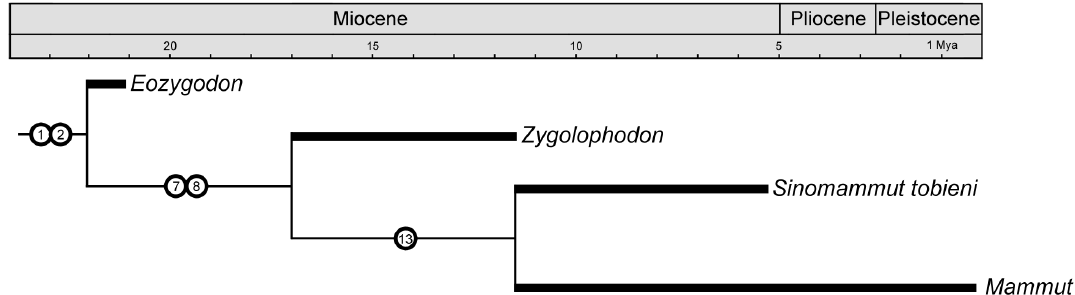
Figure 5 - Phylogenetic hypothesis of the family Mammutidae including the new mastodon Sinomammut tobieni . Diagnostic characters and states are described on Table